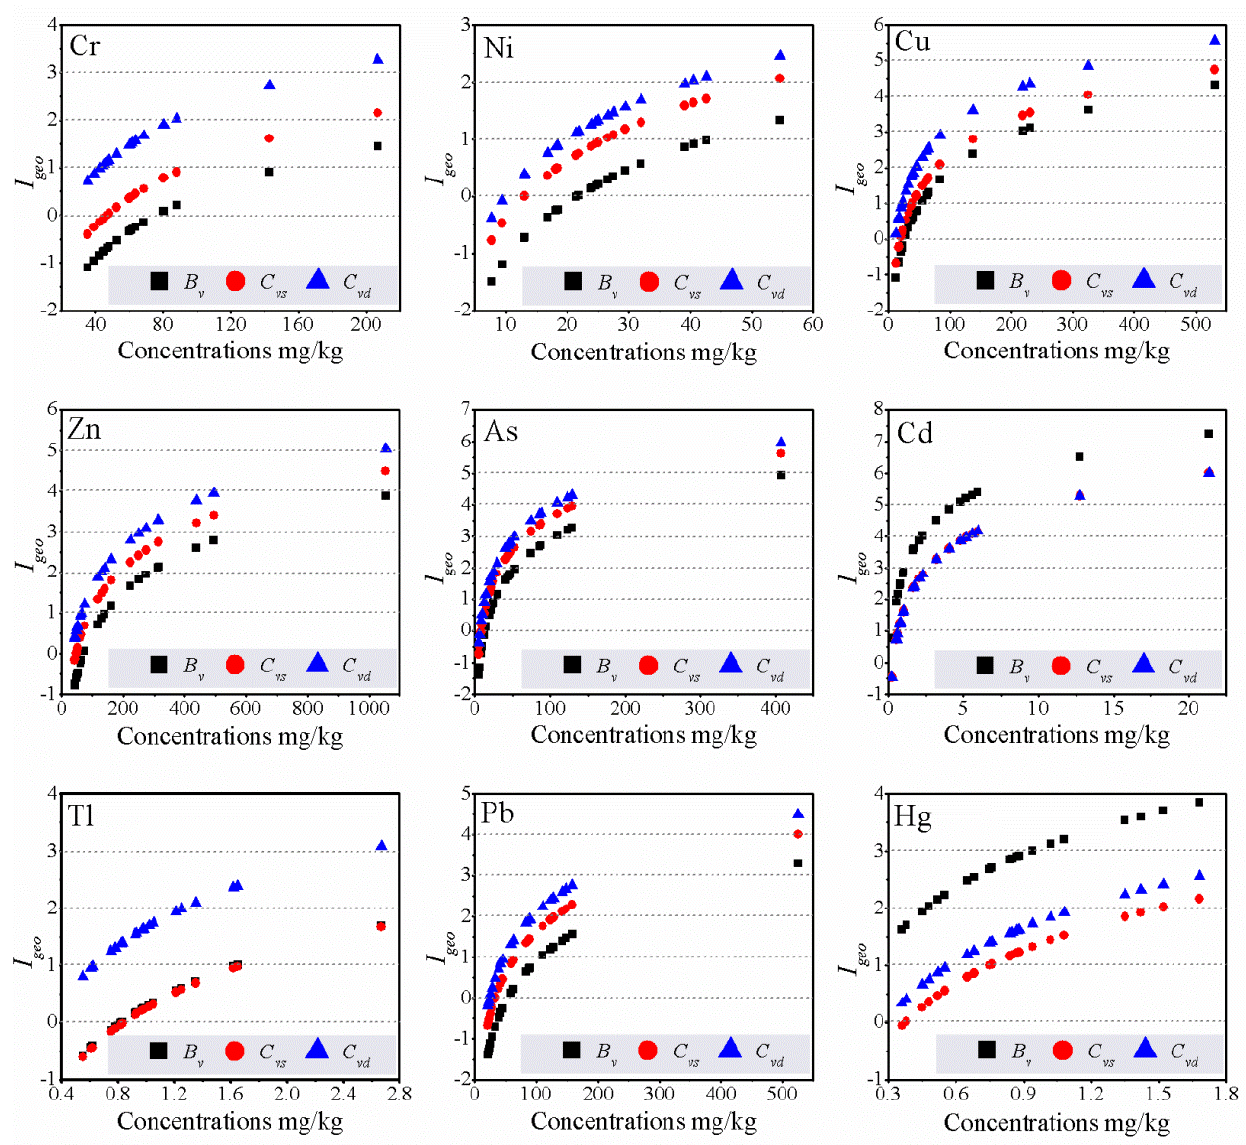
Figure 2. The I geo values of Cr, Ni, Cu, Zn, As, Cd, Tl, Pb, and Hg in sediments were calculated based on different types of background values and total concentrations.